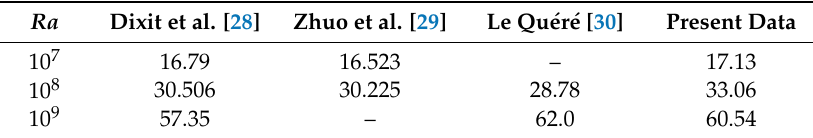
Table 2. Variation of the average Nusselt numbers.